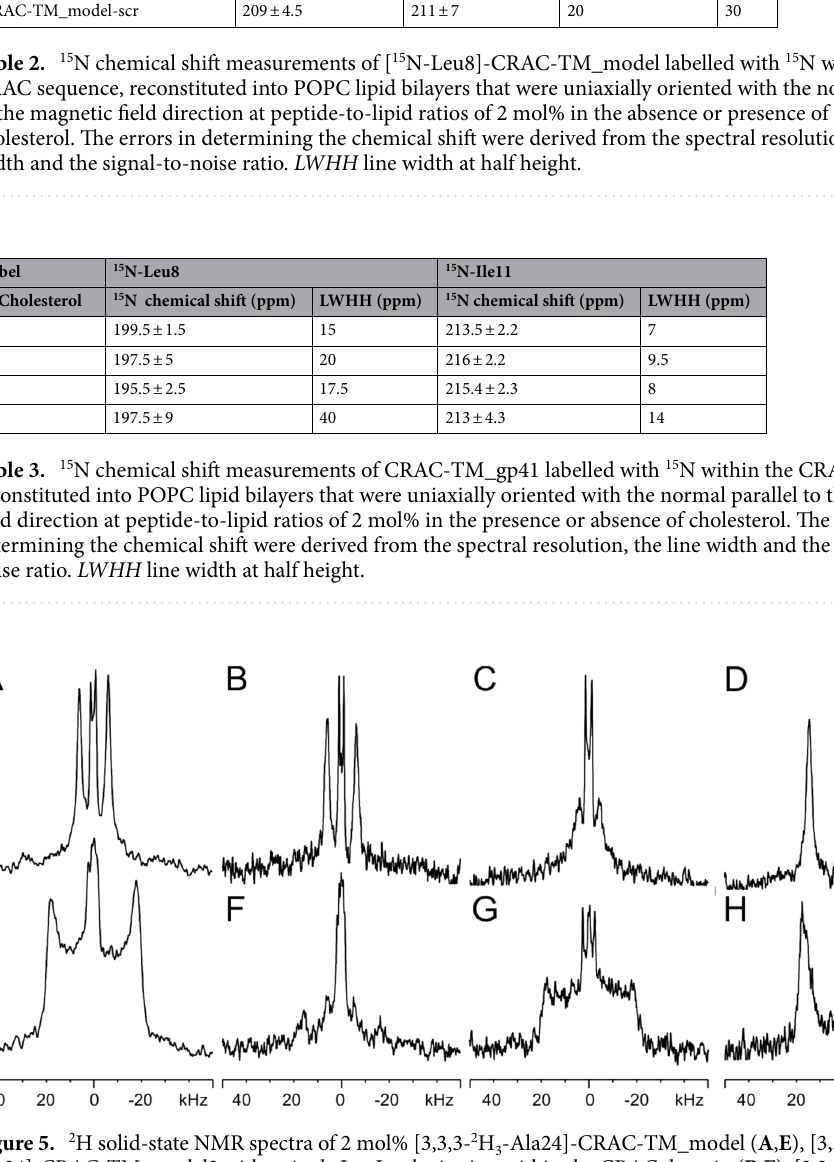
Solid-state NMR spectra of deuterated cholesterol. Whereas in the experiments just presented the effects of cholesterol on the structure and alignment of the CRAC-TM sequences were tested (Figs. 4 and 5, Tables 2, 3 and 4) a complementary view on these interactions is obtained from NMR spectra of the surrounding lipids. Therefore, in the next series of experiments, the 2 H solid-state NMR spectra of deuterated cholesterol were recorded in order to monitor its interactions with the CRAC-TMD sequences in liquid crystalline bilayers. Cho- lesterol was deuterated at either six sites at the 2, 3, 4 and 6 positions, which are expected to locate in the interfa- cial region in mixed phospholipid/cholesterol membranes, or at seven sites of carbons 25, 26 and 27 which reside